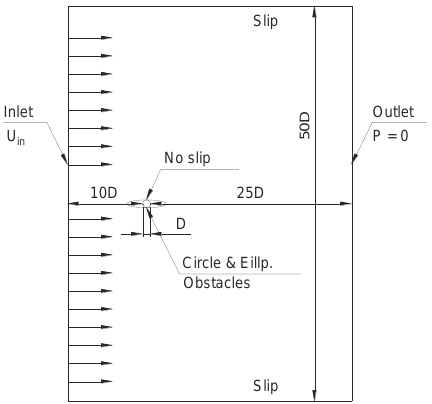
Figure 7. Computational domain and boundary conditions for the external flow around a body of circular or elliptic shape.